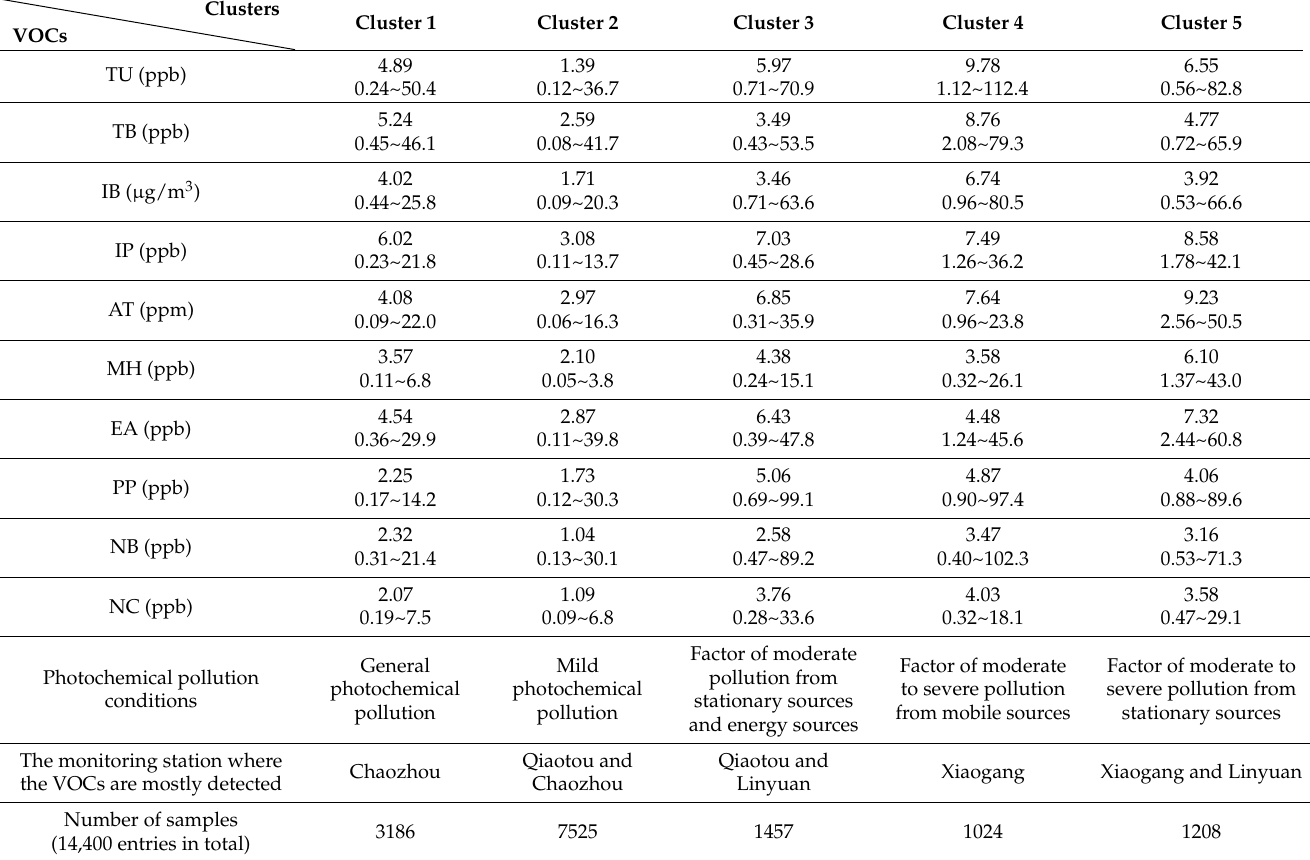
Table 4. Average and maximum values for the VOCs in various